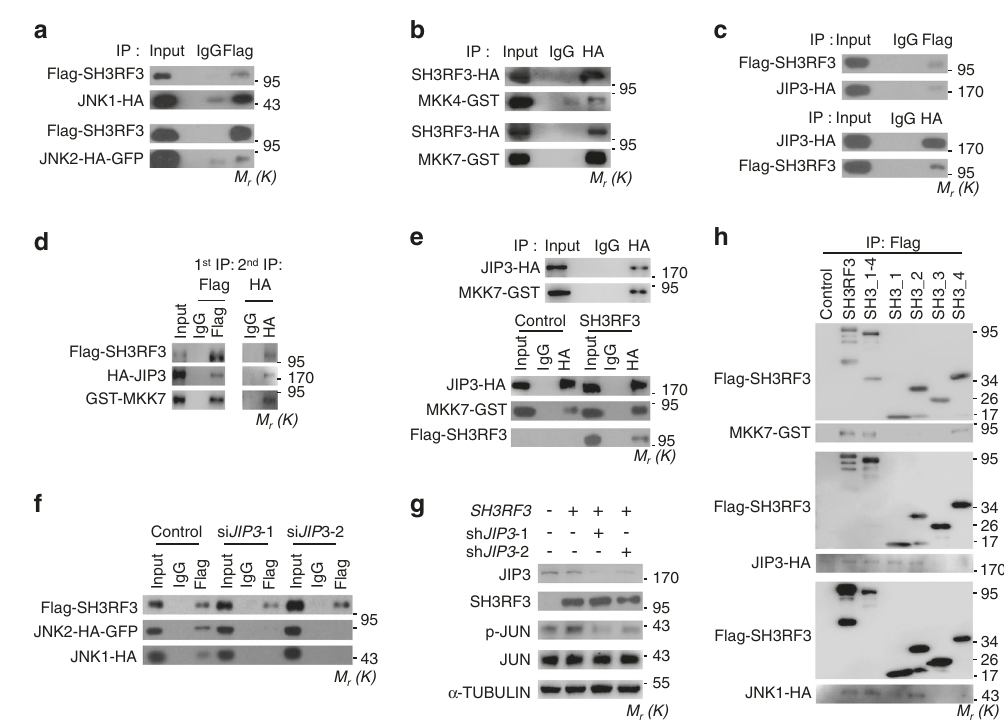
Fig. 7 SH3RF3 activates JUN by interacting with MKK and JNK. a Co-IP analyses of SH3RF3-JNK1/2 interaction in 293T cells. b Co-IP analyses of SH3RF3-MKK4/7 interaction in 293T cells. c Co-IP analyses of SH3RF3-JIP3 interaction in 293T cells. d Sequential Co-IP analyses of SH3RF3-JIP3-MKK7 interaction in 293T cells. e Co-IP analyses of JIP3-MKK7 interaction in MCF10AT (top), and with or without SH3RF3 overexpression (bottom). f Co-IP analyses of SH3RF3-JNK1/2 interaction in MCF10AT with or without JIP3 knockdown. g JUN phosphorylation after SH3RF3 overexpression and JIP3 knockdown in MCF10AT. h Co-IP analyses of the interactions of various SH3RF3 truncations to MKK7, JIP3, and JNK1. The experiments were repeated three times independently with similar results, and the data of one representative experiment are shown. Source data are provided as a Source data fi